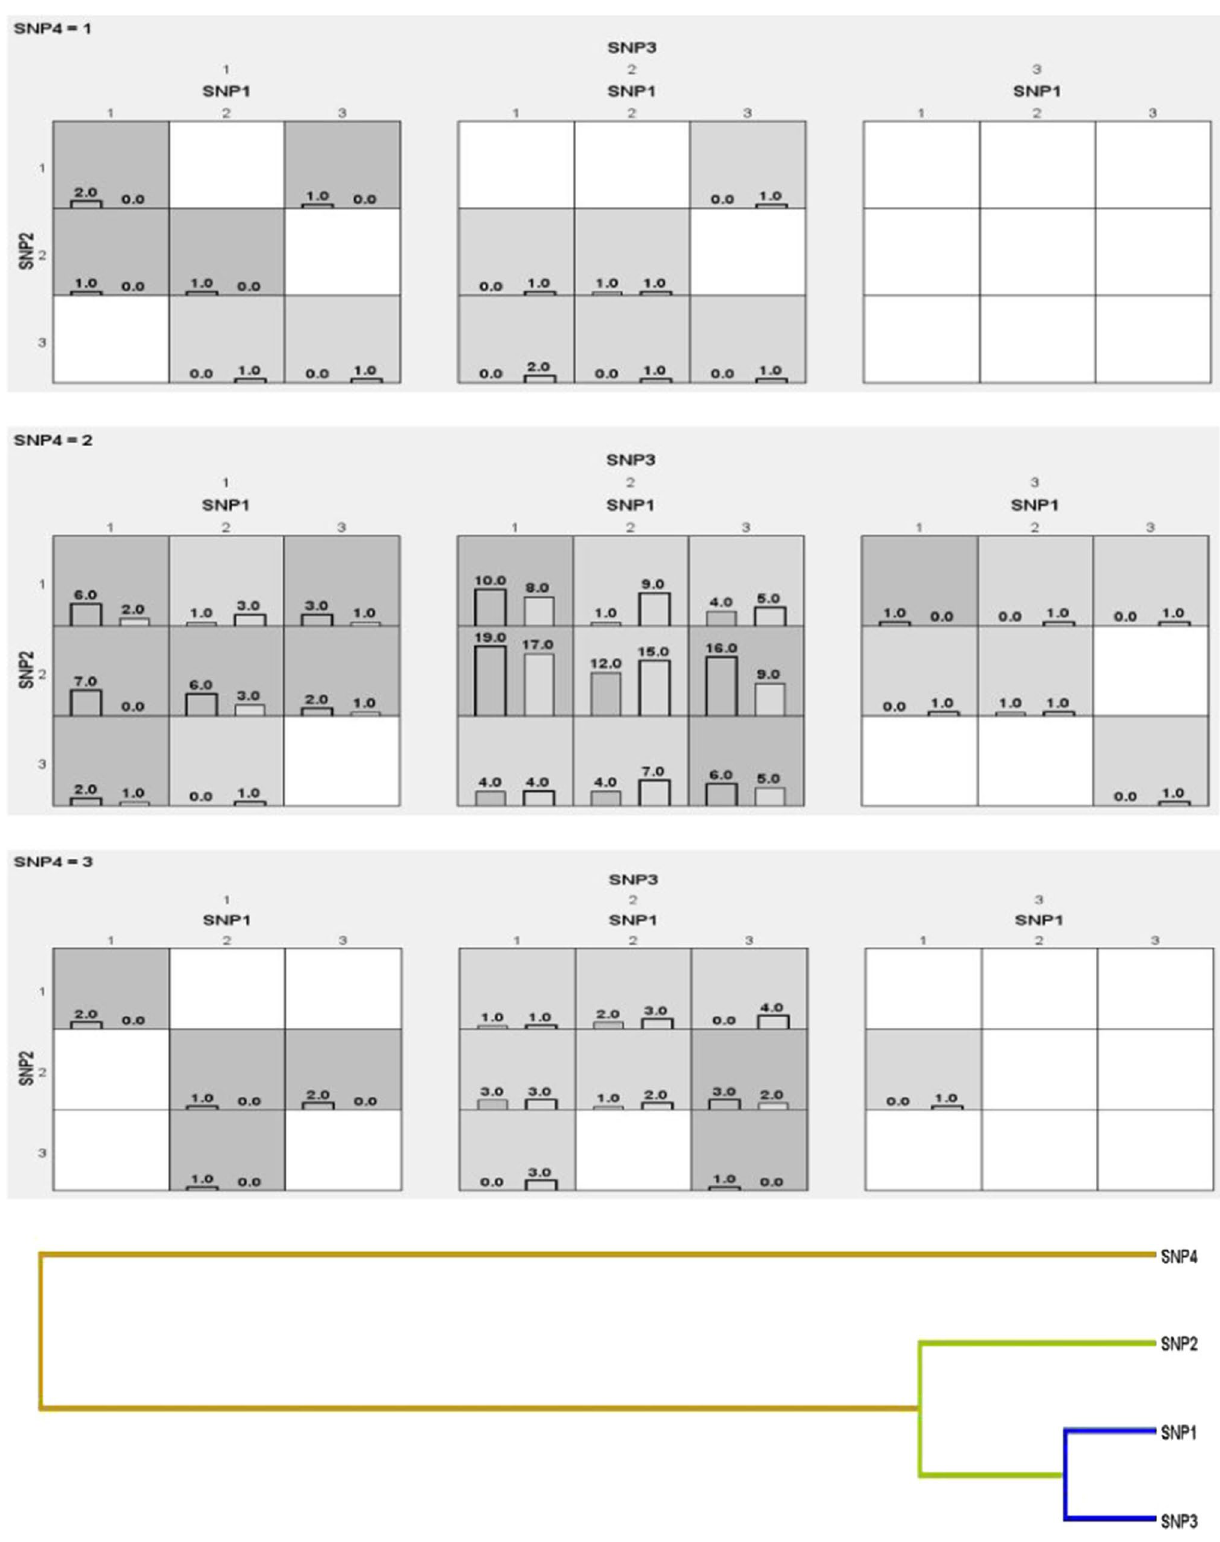
Fig. 1 Gene-gene interaction between the 4 SNPs. SNP1;FOXP3 (rs3761549C/T), SNP2;FOXP3(rs3761548C/A), SNP3; ROR-γ (rs9017 A/G),SNP4; ROR-γ (rs9826 A/G). Dark Boxes describe the high risk for ALL versus control between the three genotypes of the four SNPs. The lightly shaded box showed low-risk